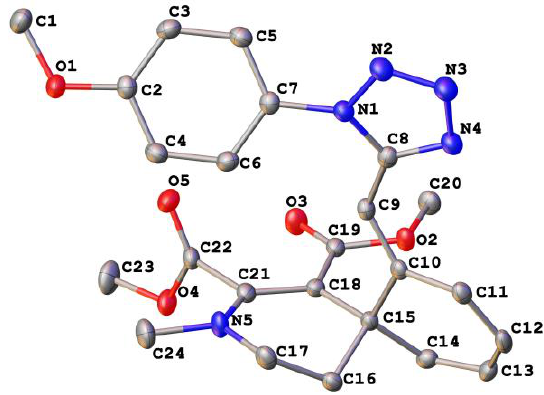
Figure 1. X-ray crystal diffraction of compound 3 .